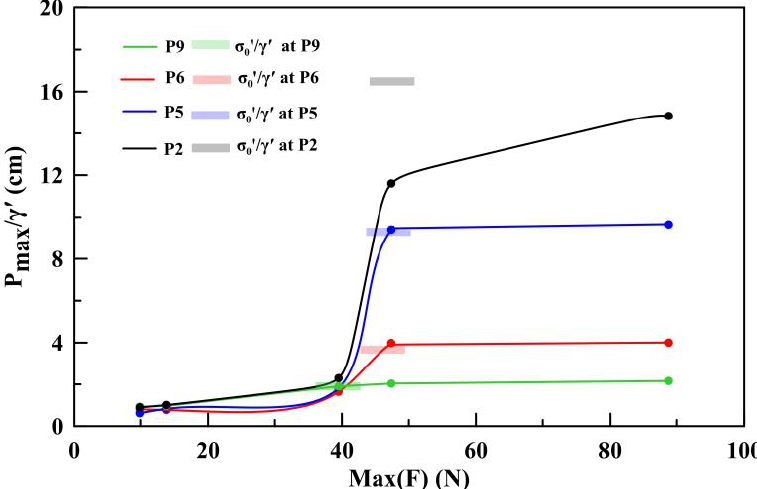
Figure 7. Measured accumulative pore pressure, P max , under different magnitudes of cyclic loading of the vibrating pipeline in Tests 7 and 8 at the same burial depth.